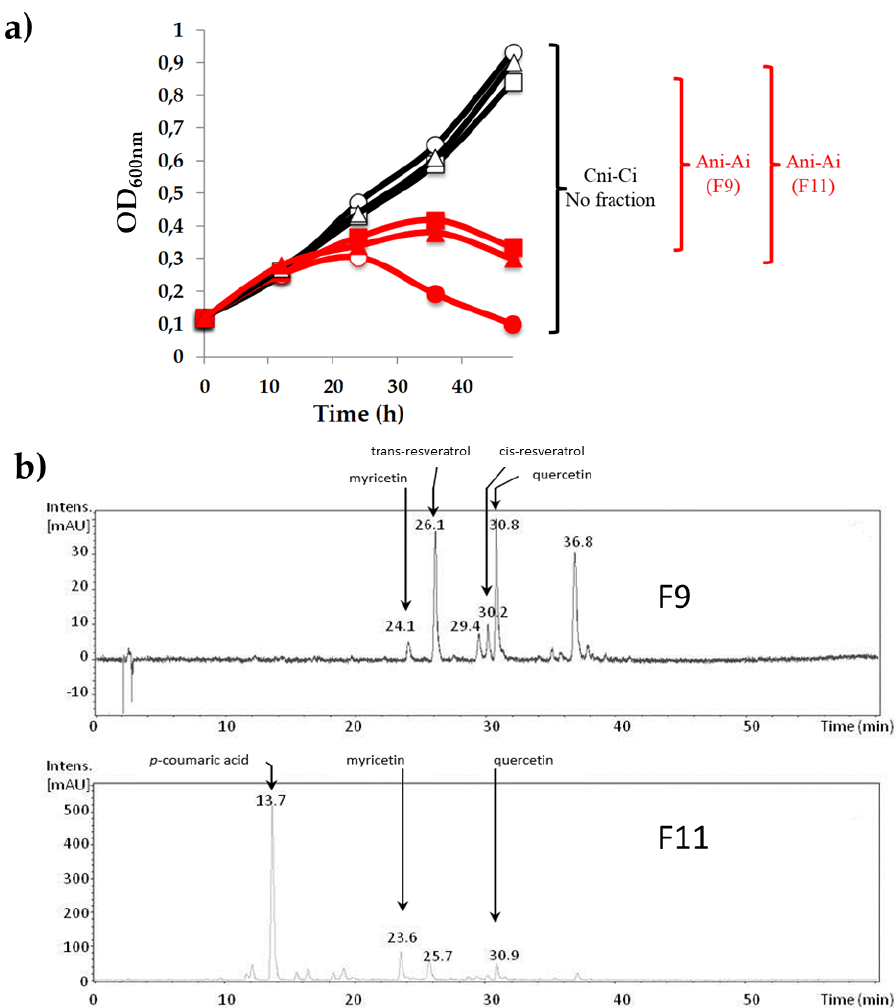
Figure 1. Phenolic fractions F9 and F11 reduce the killing activity of phage OE33PA on Oenococcus oeni in Man Rogosa Sharpe (MRS Φ ) broth. ( a ) black curves correspond to the three non-infected (ni) cultures: the control culture without fraction (Cni, ◯ ) and assays with 10 µl of fraction 9 (F9) (Ani, □) or fraction 11 (F11) (Ani, △ ). Red curves correspond to the three cultures infected with phage OE33PA with a multiplicity of infection (MOI) of 0.003, the control without fraction infected (Ci, ●) and infected assays (Ai) with fractions 9 ( █ ) or 11 ( ▲ ). Fractions F9 and F11 contained 7.95 ± 2.14 and 74.32 ± 1.98 mg GAE mL −1 , respectively. ( b ) LC chromatograms at 306 nm of the F9 and F11 fractions. Peak identification was based on (i) analysis of the retention times (values are given), wavelengths of maximum absorbance (λmax), pronated molecules ([M+H] + ) and major fragment ions (MS/MS in positive mode) and (ii) comparison with published literature [28–30]. The major PCs contained in both biologically active fractions were identified using a reverse phase HPLC system coupled with an MS (Figure 1b). Fractions F9 and F11 showed the presence of 9